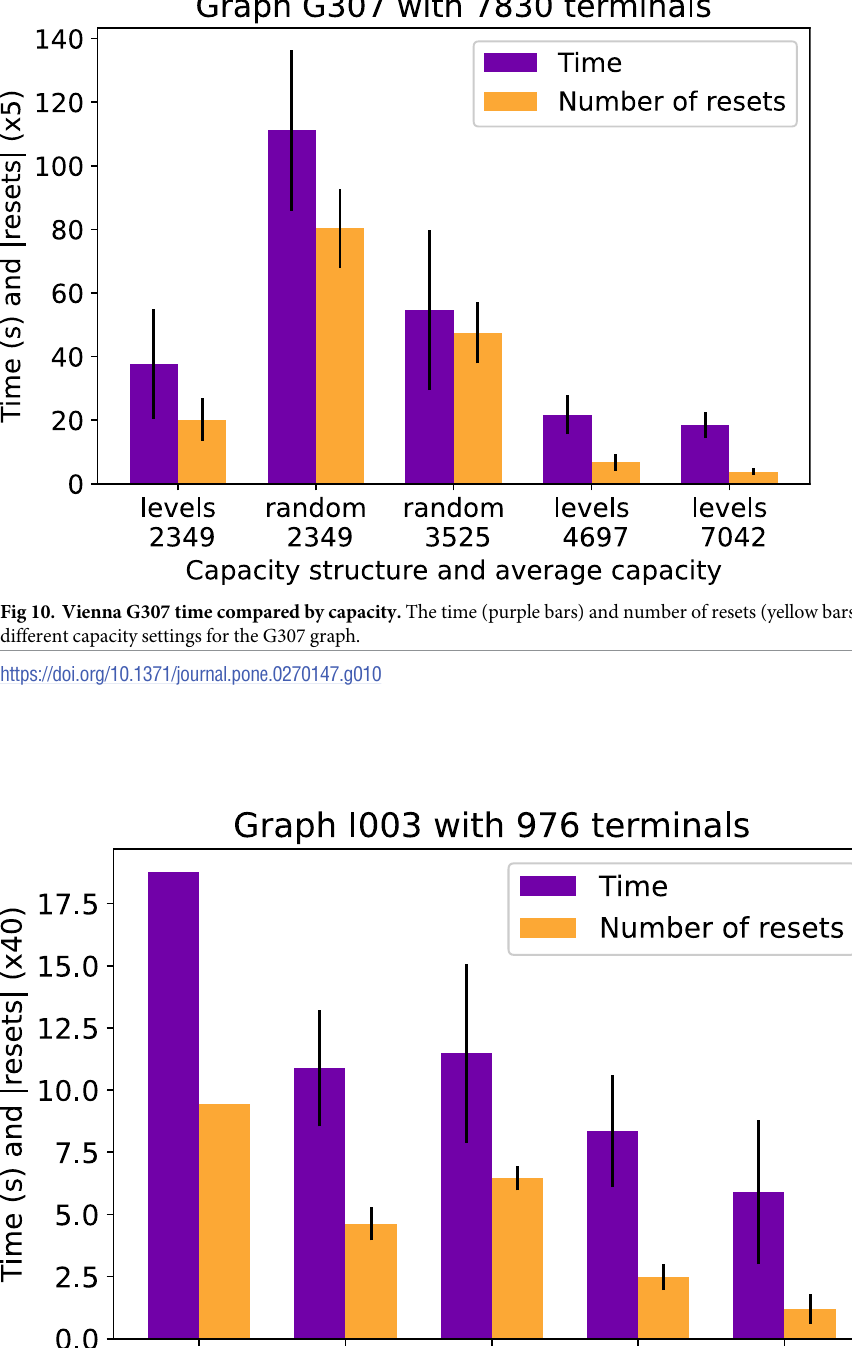
PLOS ONE | https://doi.org/10.1371/journal.pone.0270147 June 16,